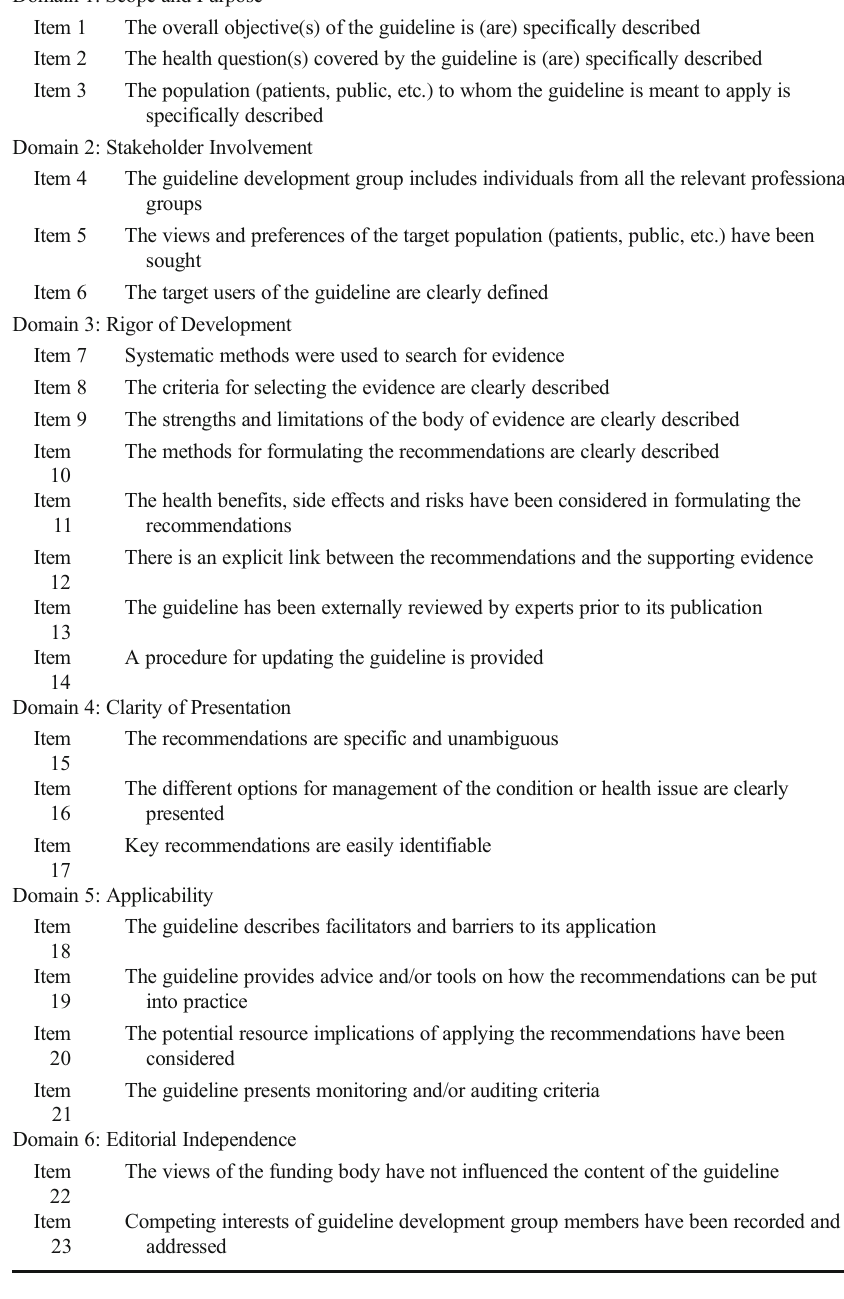
Table 1 Summary of AGREE II structure and detailed list of items within each domain (from reference